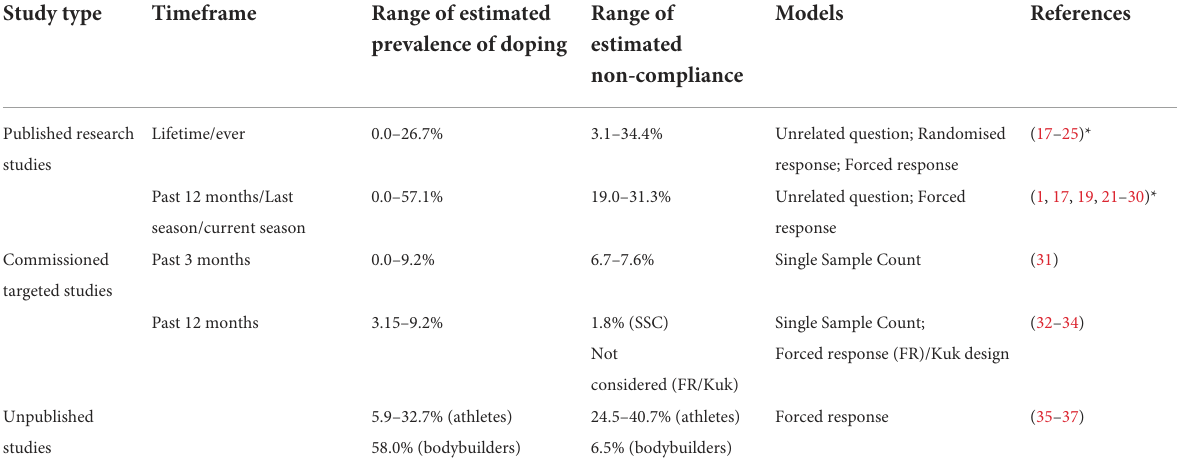
TABLE 1 Summary of studies estimating doping prevalence in elite sport using indirect (randomised and non-random) estimation